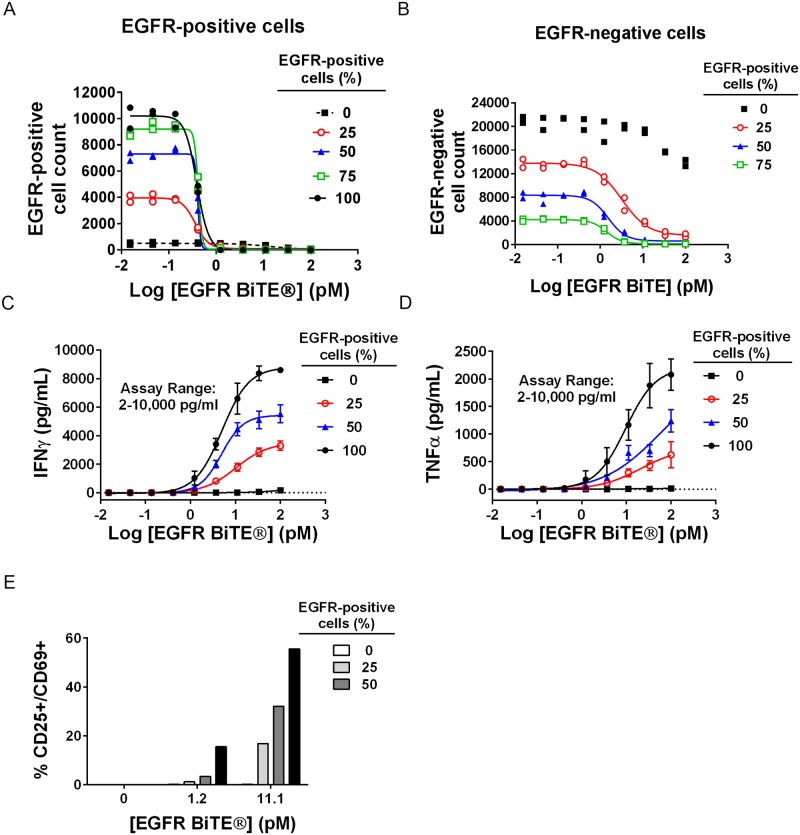
EGFR-negative bystander cells were lysed by BiTE®-activated T cells when co-cultured with EGFR-positive cells.NUGC4 (EGFR-positive) and SW620 (EGFR-negative) cells were mixed in various ratios and incubated with T cells (E:T ratio 10:1) and EGFR BiTE® in duplicate plates. Thousands of cells/well were analyzed, with good agreement between replicate plates. This result was reproducible (S2C Fig). After 48 hours, cells were stained and analyzed as describe in Materials and Methods. Cytotoxicity of (A) EGFR-positive and (B) EGFR-negative cells was measured by nuclear count (N = 2, all data points shown). (C) IFNγ and (D) TNFα were measured using commercially available MSD assays (N = 3, mean +/- sd). (E) T cells from quadruplicate wells were combined and percent CD69+/CD25+ cells determined by flow cytometry.